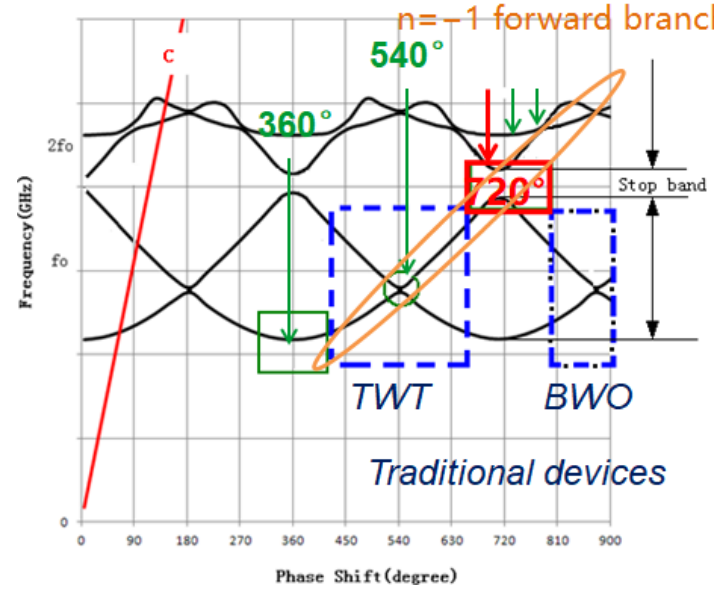
Figure 5. Dispersion curves of a traditional folded waveguide circuit. For the fully symmetric folded waveguide slow-wave structure, there is no stop band at phase shift of 540 ◦ in theory. However, due to the machining, the actual slow wave structure will have a certain asymmetry, which may result in a stopband at the phase shift of 540 ◦ [12]. This stopband may affect the matching characteristics at the frequency, which may depress the output power at this frequency. In addition, it may result in the undesired 3 π oscillations. Therefore, phase shift of 540 ◦ is usually avoided to fall into the operating frequency band when designing the folded waveguide slow-wave